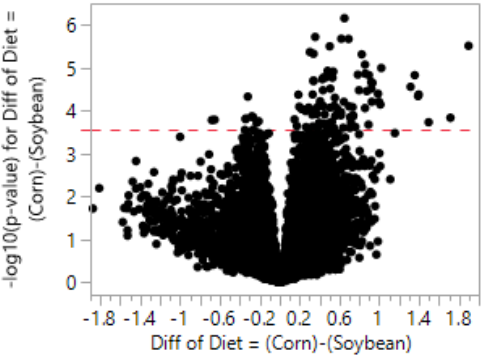
Figure 2. Volcano plot of NGS-identified transcripts using upper quartile scaling normalization. The x -axis displays the difference in log scale, and the y -axis plots the –log10( p -value) for each transcript, represented by a point. Significance threshold is graphed with a dotted red line (3.550). Points to the right of 0 and above the significance threshold are significantly increased transcripts and transcripts that are significantly decreased are to the left of 0 and above the threshold line.